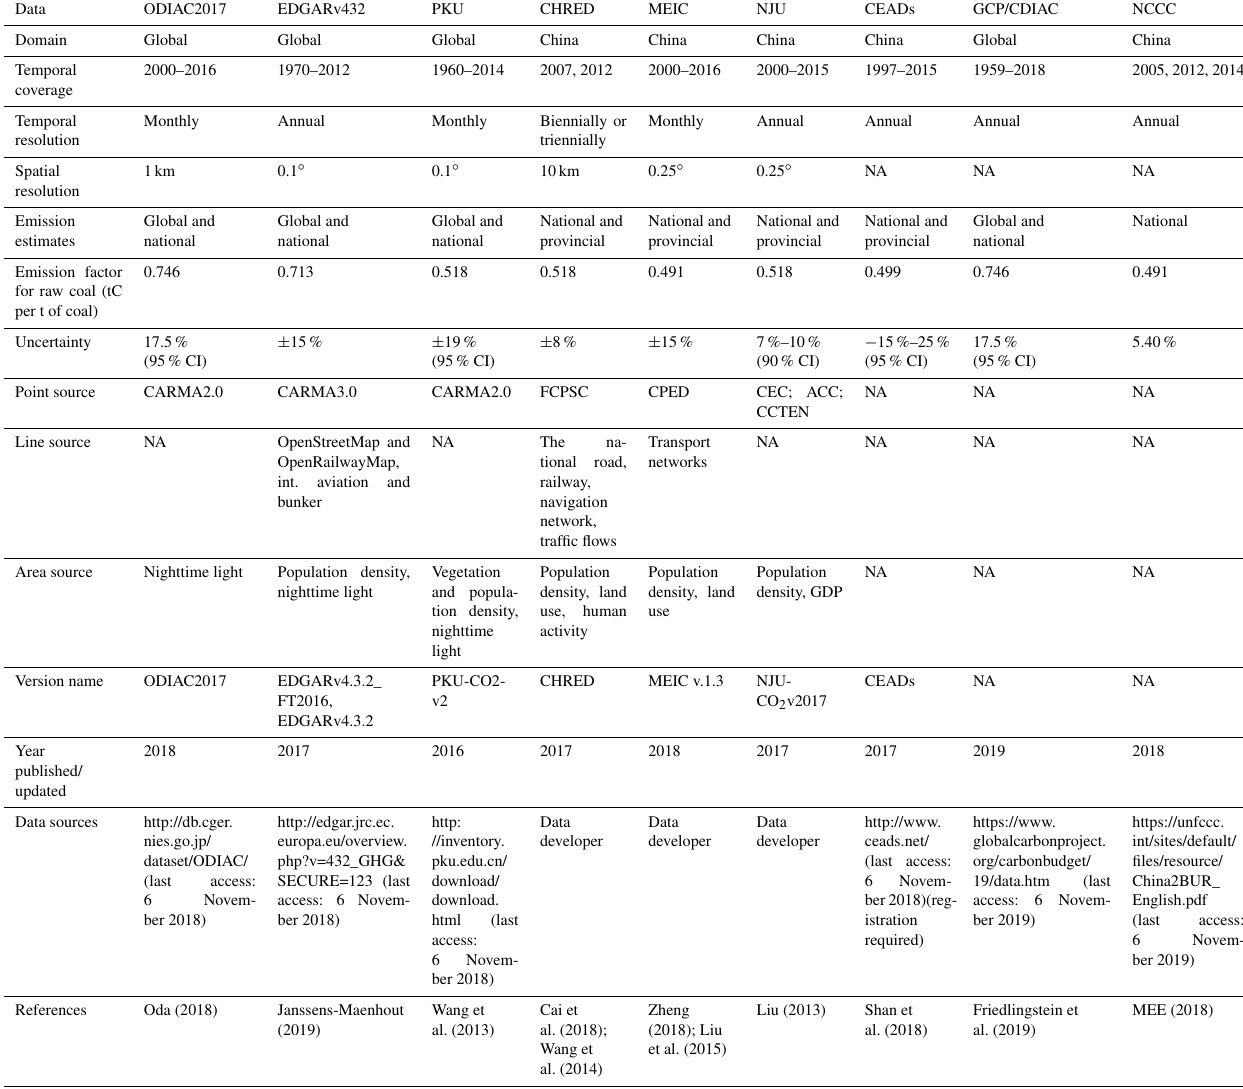
Table 1. General information of the emissions datasets ∗